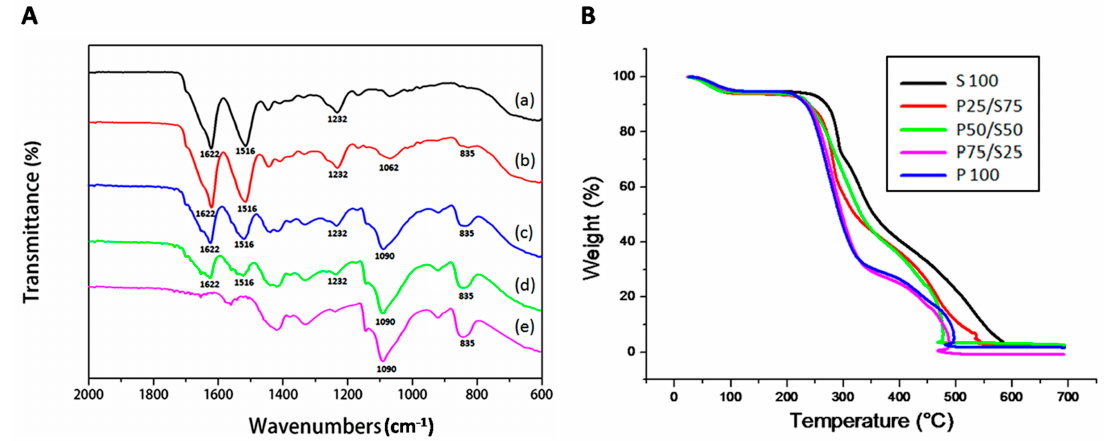
Figure 4. ( A ) FTIR spectra; ( a ) S100; ( b ) P25/S75; ( c ) P50/S50; ( d ) P75/S25; ( e ) P100; and ( B ) Thermogravimetric analysis.